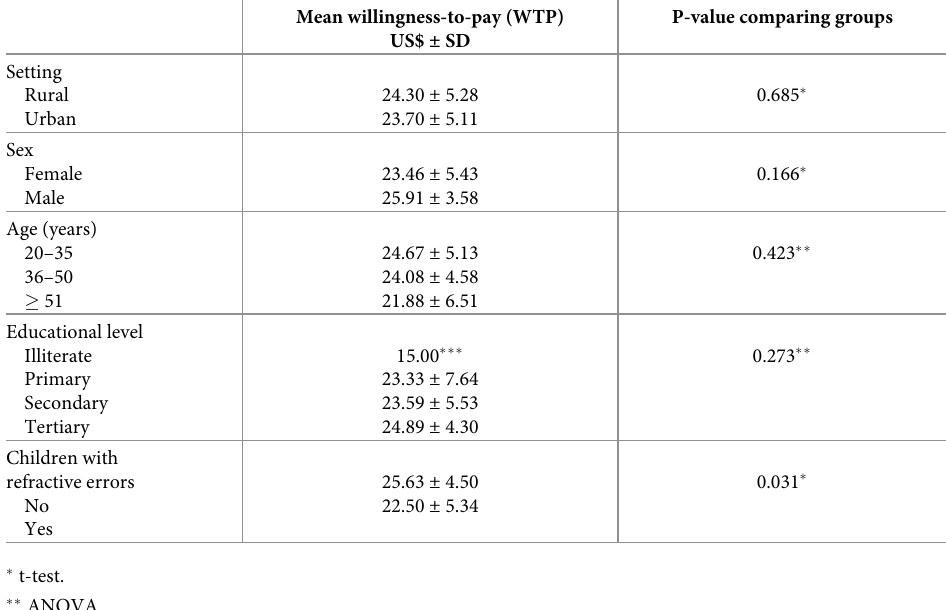
Table 3. Potential predictors of mean willingness-to-pay